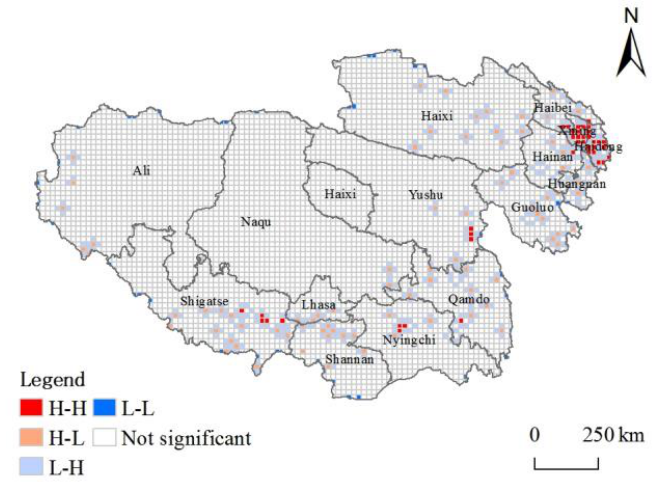
Figure 5. Local autocorrelation of high-grade tourist attractions on the Tibetan Plateau